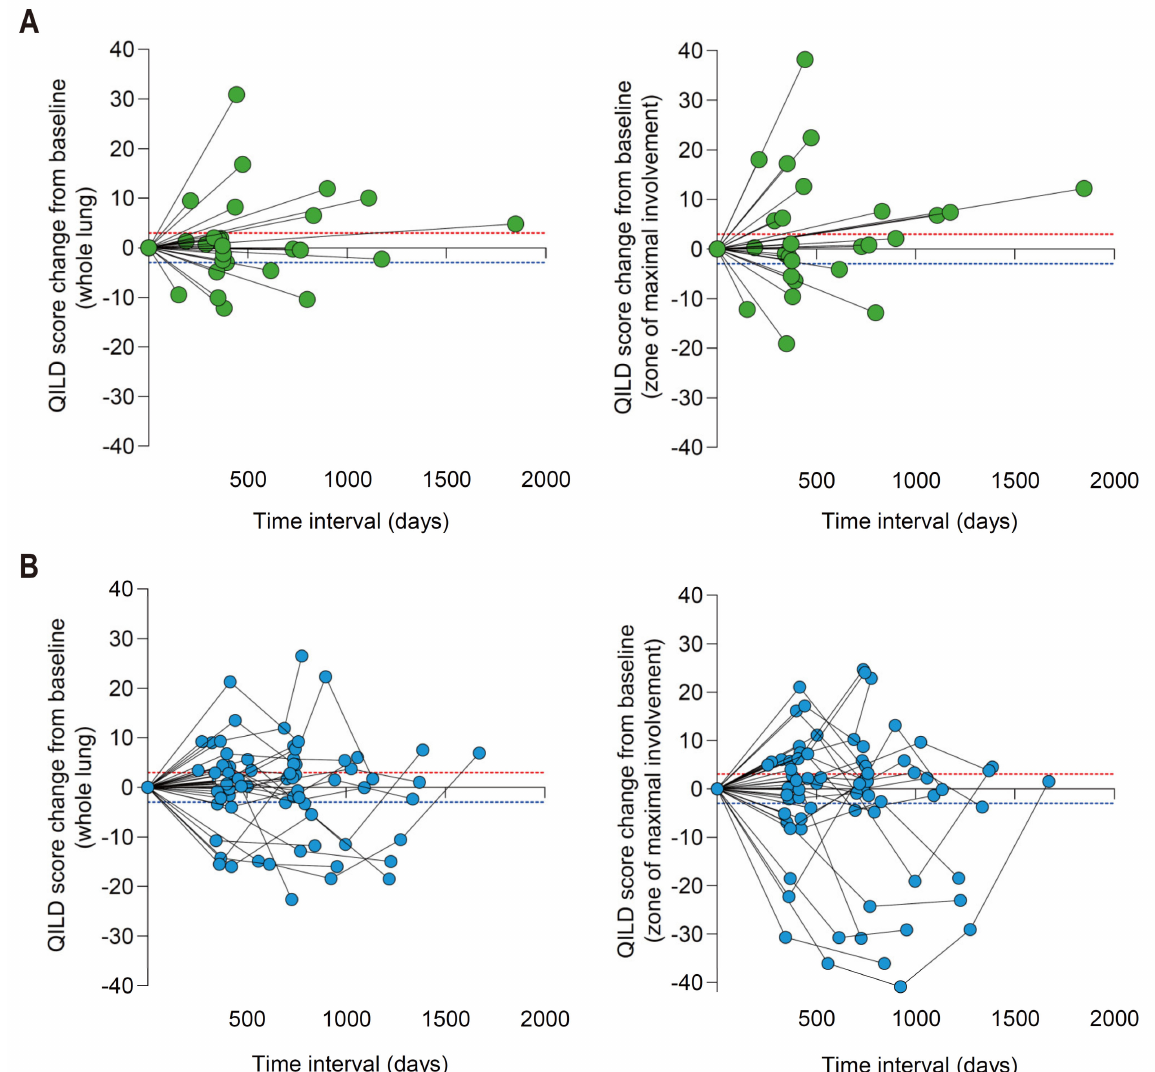
Figure 4. Changing patterns of QILD scores in whole lung (left panels) and lobe of maximal involvement (right panels). ( A ) Cohort 1 ( n = 26). ( B ) Cohort 2 ( n = 34). Red dashed line: +3; Blue dashed line: −